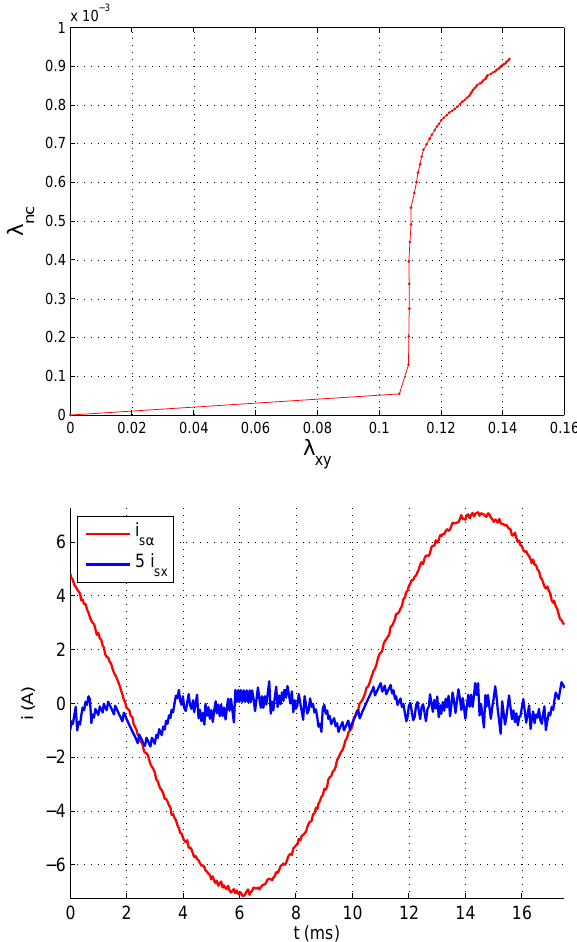
Figure 9. Evolution of ( λ xy , λ nc ) using the simplified MIT rule ( top ) and waveforms for a time period were the adaptated parameters are close to their final value Λ = ( 0.14, 9 × 10 − 4 ) ( bottom